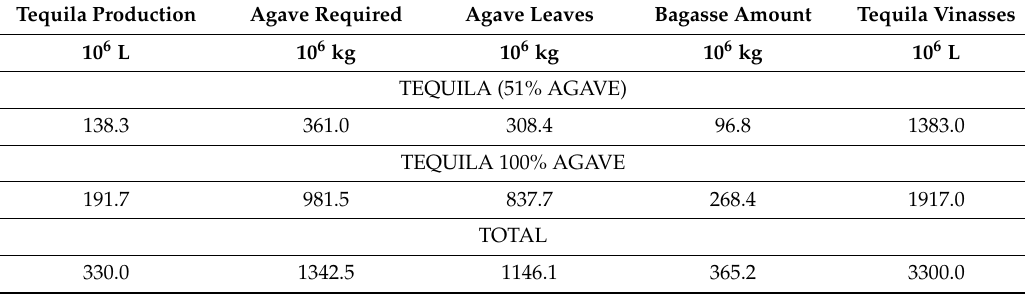
Table 1. Tequila, agave, and residues estimate data in 2019. Adapted from CRT